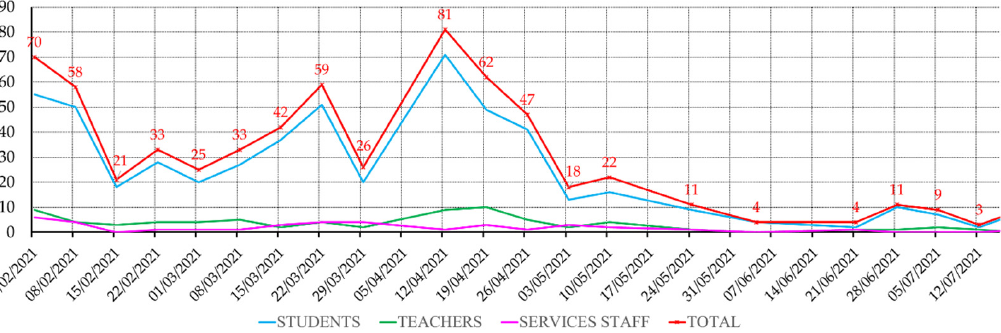
Figure 2. Evolution of the number of cases reported to the different university schools and faculties as registered by the UPV/EHU Surveillance Committee.